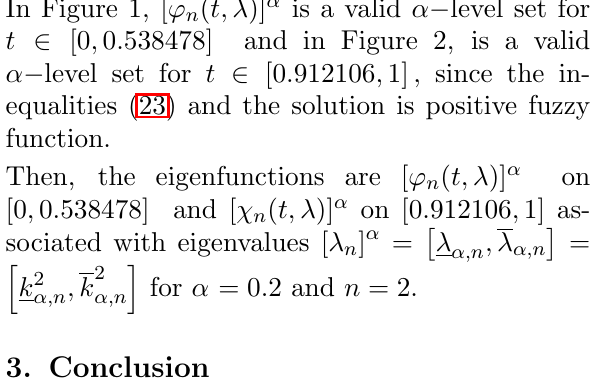
Figure 2. Graphic of [ χ n ( t, λ )] α : Red → χ → χ ( t, λ ), Green → χ α,n χ 1 ( t, λ ,n